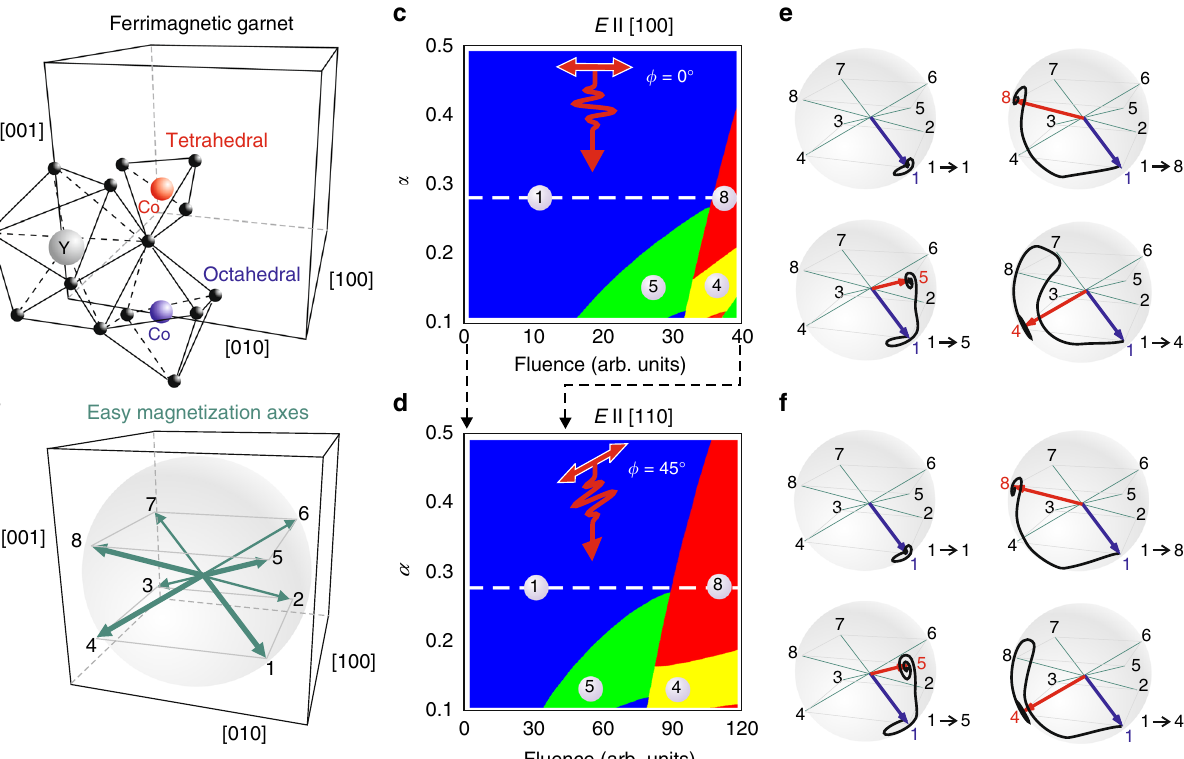
Fig. 1 Photo-magnetic switching in YIG:Co. a Crystal structure of iron garnet. Co-ions can enter the crystal by taking the positions in octahedral and tetrahedral environments. b Eight metastable states of the magnetization in relation to the crystal symmetry of iron garnet. c Phase diagram of the photo- magnetic switching from state 1 with light polarization E || [100] as a function of Gilbert damping α and light fl uence. The white dashed line shows the value α = 0.28. d Phase diagram of the photo-magnetic switching from state 1 with light polarization E || [110] for as a function of Gilbert damping α and light fl uence. The white dashed line shows the value α = 0.28. e Trajectories of the switching from state 1 to states 4, 5, and 8 using light polarization E || [100]. f Trajectories of the switching from state 1 to states 4, 5, and 8 using light polarization E || [110]. In all shown trajectories the blue arrow is the initial magnetization state and the red arrow is the state after the switching. The trajectories calculations are performed for various damping and fl uence, based on the phase diagrams to help illustrate the switching. Trajectories of the switching from state 1 to 8 was performed for α = 0.28. The switching paths from 1 to 4 and from 1 to 5 were simulated for α = 0.12. Fit parameters for all simulations are b = − a /3, c = a /2 (see Eq. 4 in